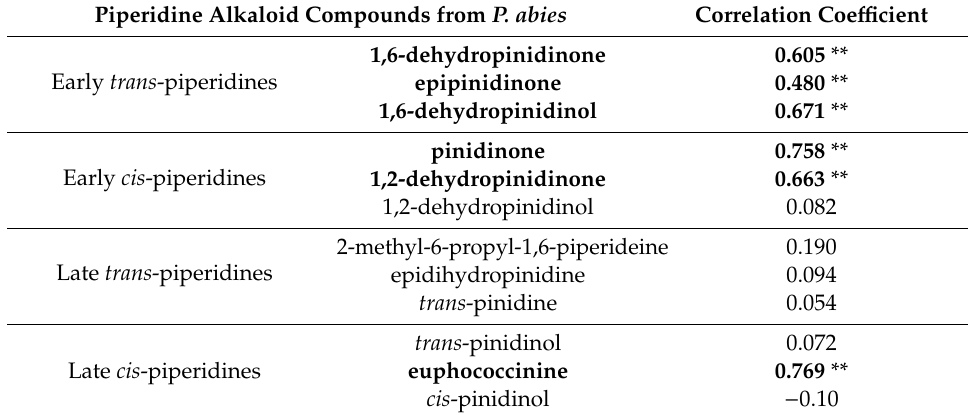
Table 3. Results of correlation analyses (Sperman’s rho) for 1,6-dehydropinidine concentration with other alkaloid compounds detected from current-year needles.